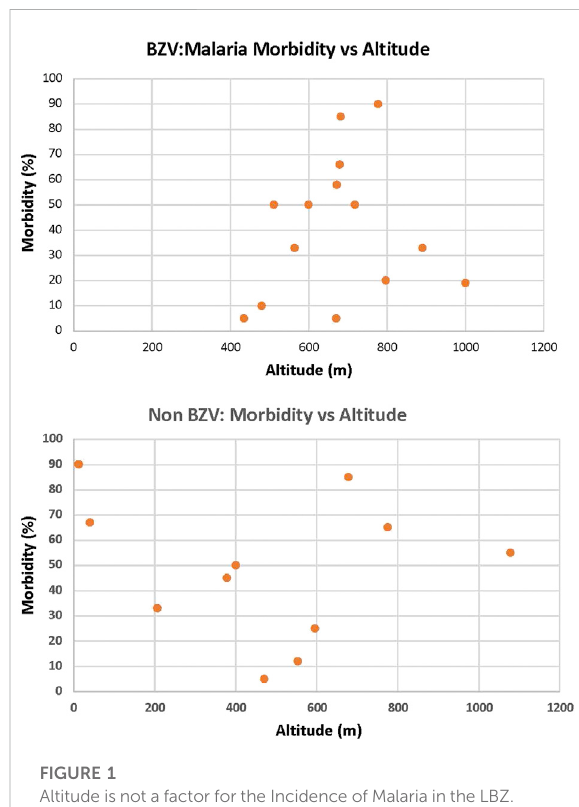
FIGURE 1 Altitude is not a factor for the Incidence of Malaria in the LBZ. Utilizing the data of Fermi (Fermi, 1934, 1938, 1940), there was no signi fi cant correlation with malaria incidence among LBZ villages (top) nor in villages in the same region that do not display longevity